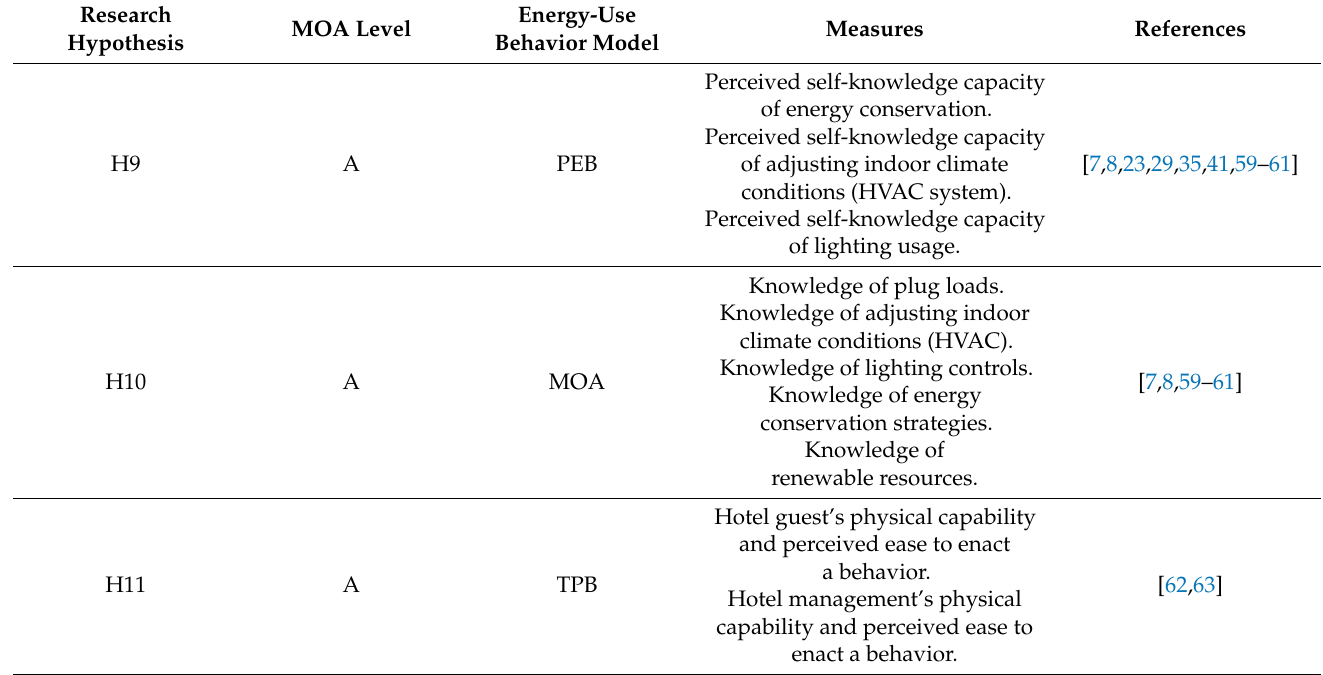
Table 3. Energy-Related Hypotheses and Measures for